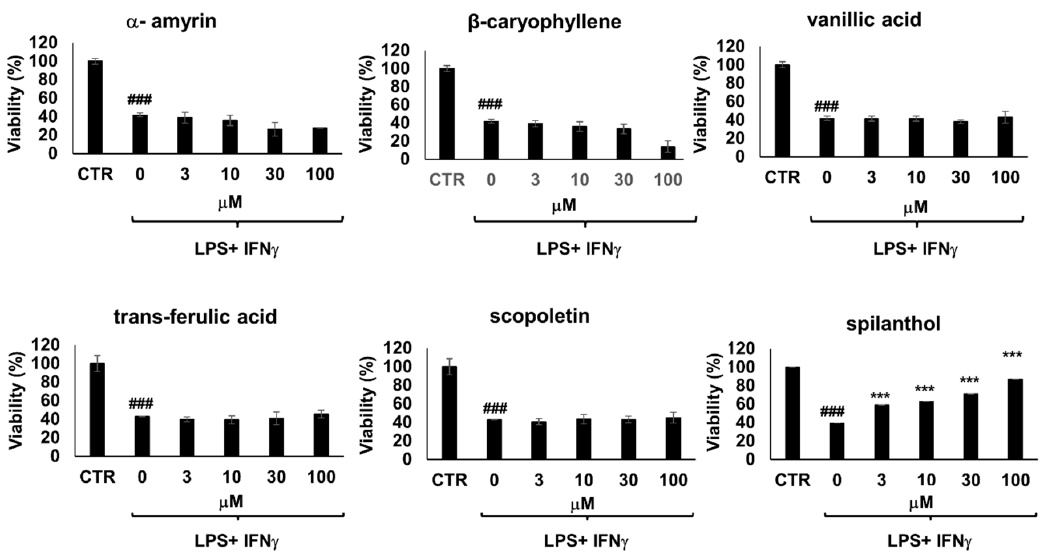
Figure 4. From a panel of selected chemical substances present in S. acmella extracts only spilanthol protects immunostimulated RAW macrophages from cell death. Cells were pretreated with the test compounds at the indicated concentrations for 2 h followed by treatment with LPS (10 ng / mL) and IFN γ (10 ng / mL) for 24 h. Cell viability was determined using MTT assay. (# Hashmarks indicate significant (### p < 0.001) decrease of viability caused by IFN γ + LPS treatment. *Stars indicate significant (*** p < 0.001) cytoprotection provided by spilanthol.). Pretreatment of immunostimulated macrophages with spilanthol reduced the level of iNOS mRNA (Figure 5A). Western blotting (Figure 5B,C) and immunofluorescent staining (Figure 5D,E) confirmed the inhibitory effect of 100 µM spilanthol on LPS + IFN γ -induced iNOS protein expression.